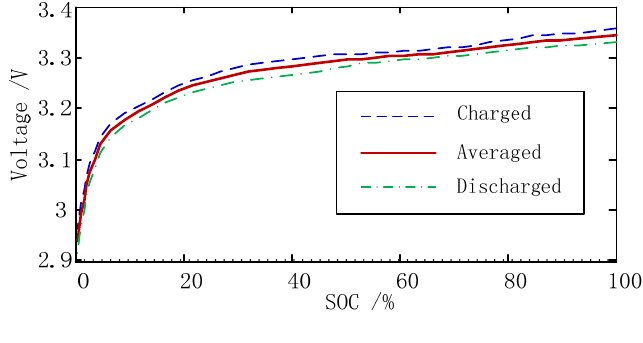
Figure 1. SOC-OCV